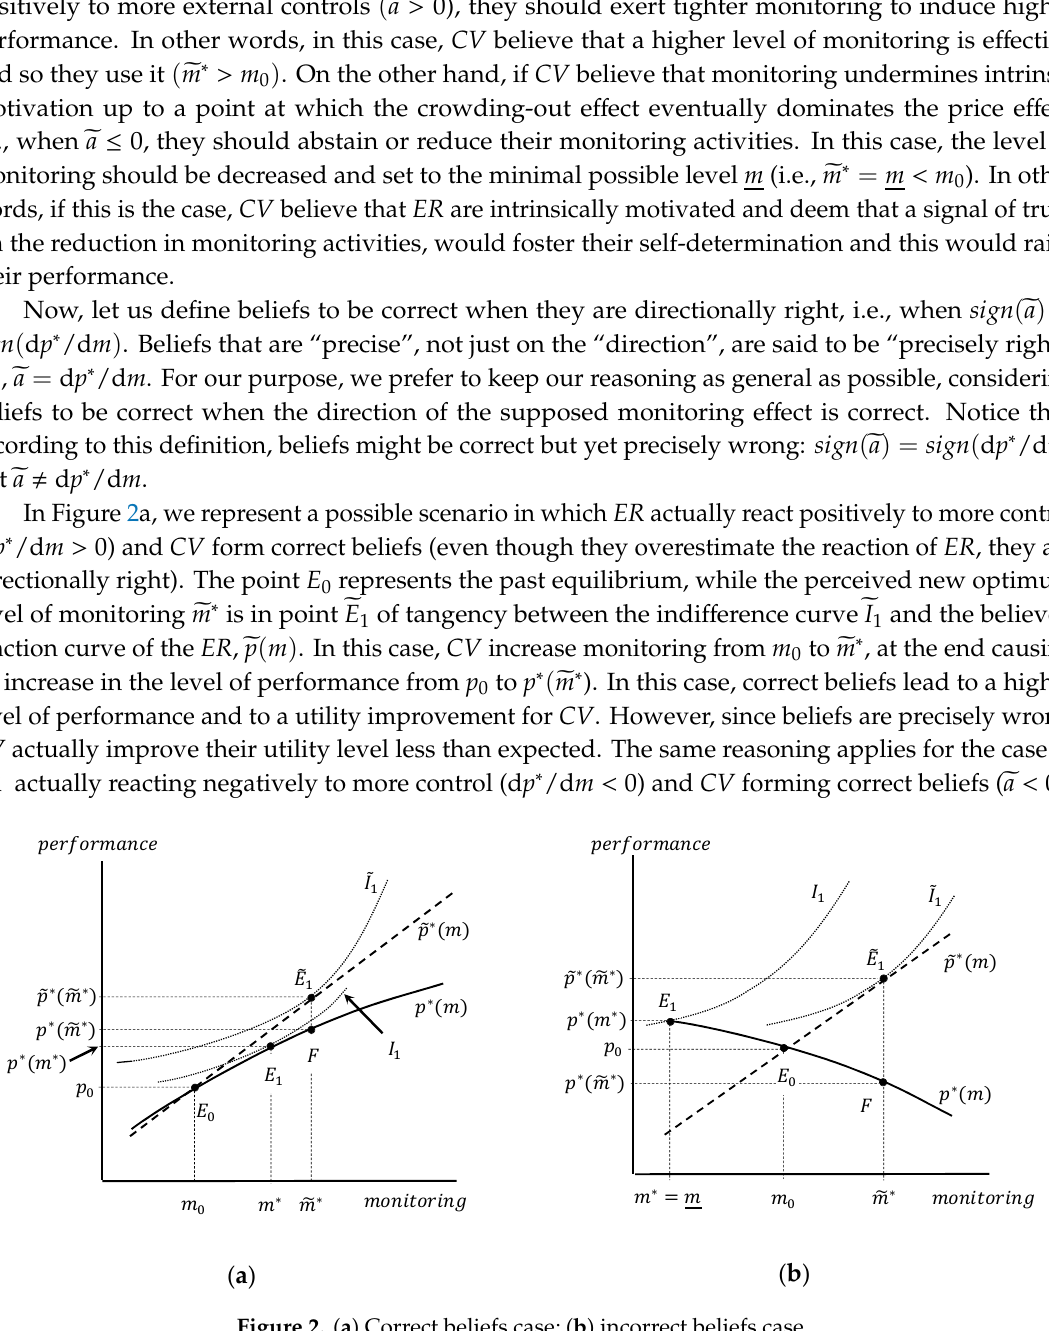
Figure 2. ( a ) Correct beliefs case; ( b ) incorrect beliefs case.